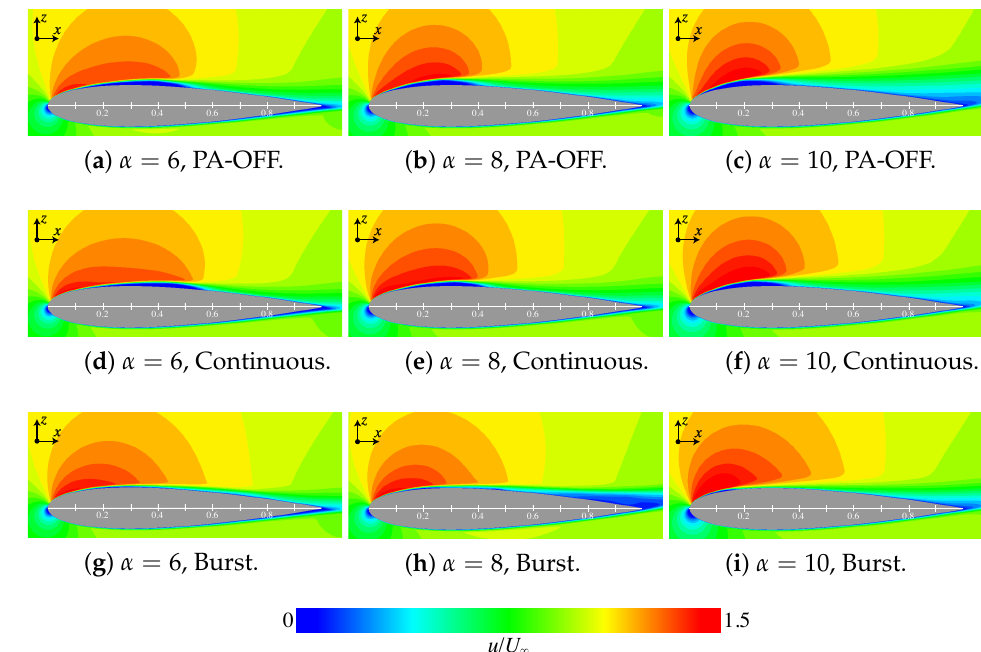
Figure 11. Time- and spanwise-averaged flows colored with the chordwise velocity ( u / U ∞